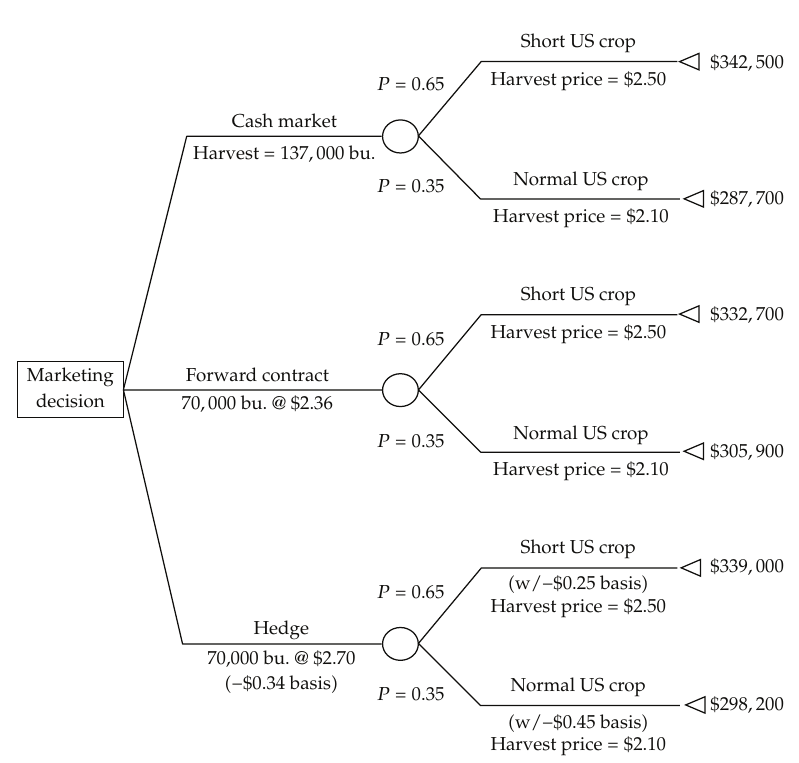
Figure 3: Decision tree for EWS Farms corn pricing decision; see source in (cid:4) 6 (cid:5)